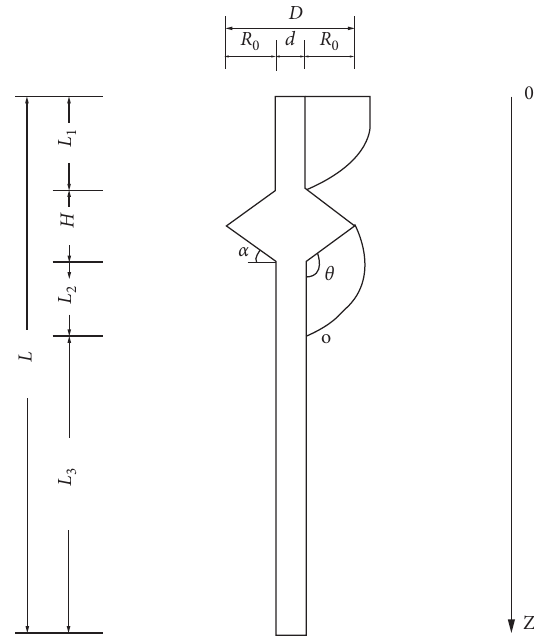
Figure 21: Stress mode of soil around a flexible expanded